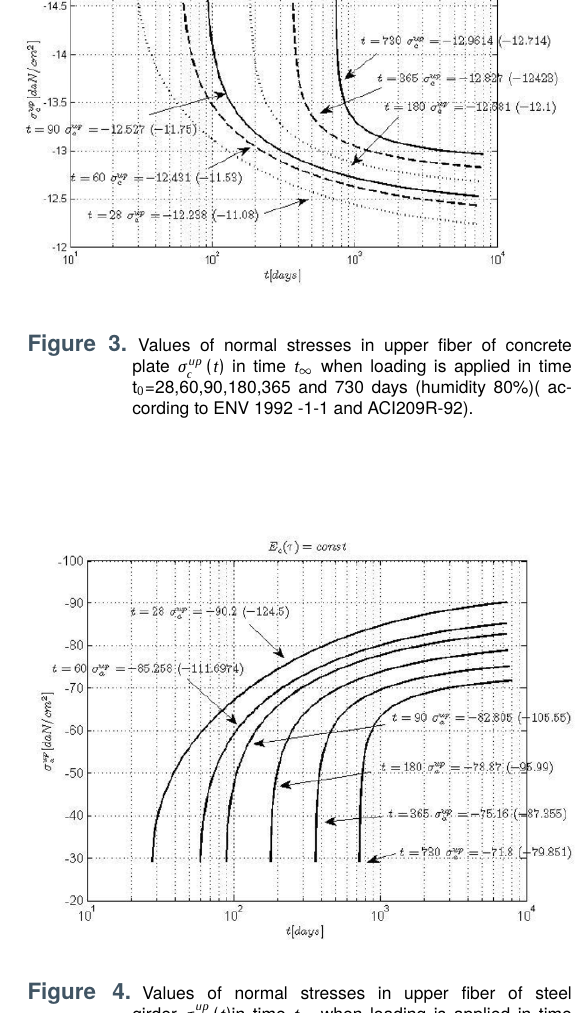
Figure 4. Values of normal stresses in upper fiber of steel girder σ up a ( t ) in time t ∞ when loading is applied in time t =28,60,90,180,365 and 730 days (humidity 8 %) (ac- 0 cording to ENV 1992 -1-1 and